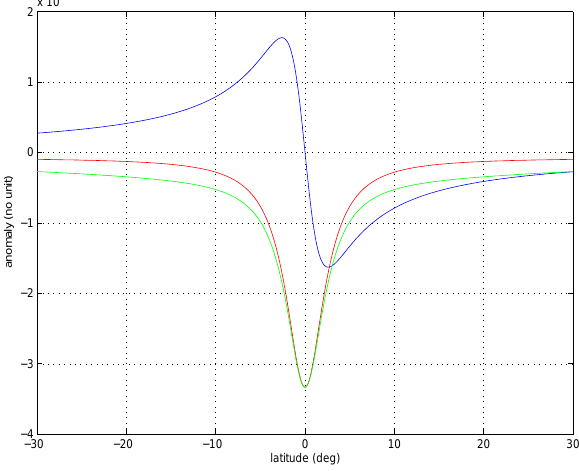
Fig. 7. Profile normal to the dip equator of the magnetic anomaly at the satellite altitude generated by a single current line along the equator when the main magnetic field is assumed axial dipolar: X component (red curve), Z component (blue curve) and F compo- nent (green curve).